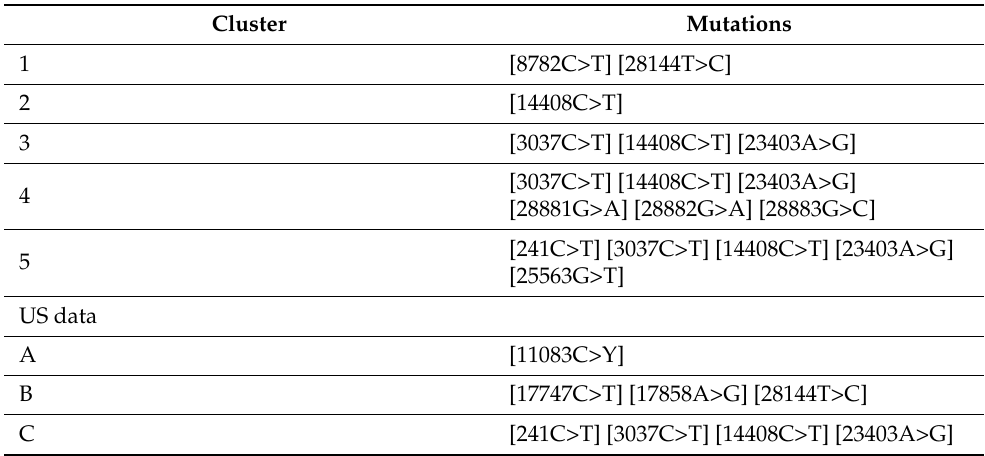
Table 2. SARS-CoV-2 genomic clusters as reported by Wang et al. [50]—worldwide